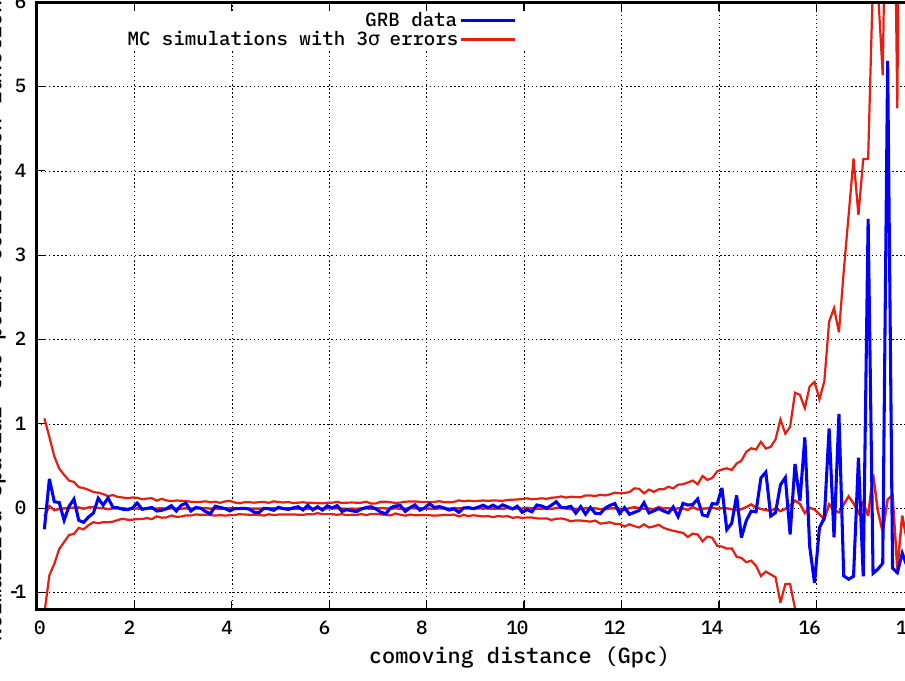
Figure 9. The Spatial Two-Point Correlation Function of the full dataset (blue) with the MC simula- tions’ mean and ± 3 σ errors (red lines).